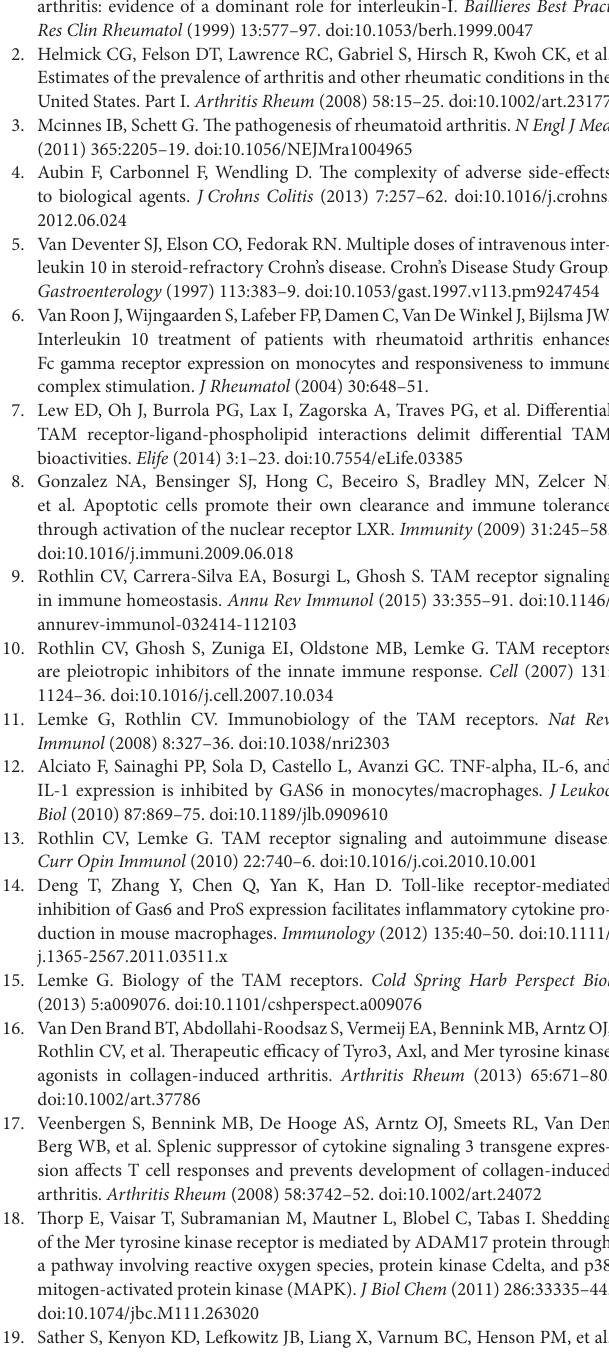
FigUre s5 | Effect of anti-MER on efferocytosis. (a) J774A.1 cells were incubated with IgG or anti-MER and cocultured with pHrodo-labeled apoptotic cells. Efferocytosis was analyzed by fluorescence microscopy ( n = 6). (b) J774A.1 cells were incubated with IgG or anti-MER, mRNA was extracted and gene expression was determined ( n = 3–4). (c) J774A.1 cells were incubated with IgG or anti-MER. Supernatants were examined